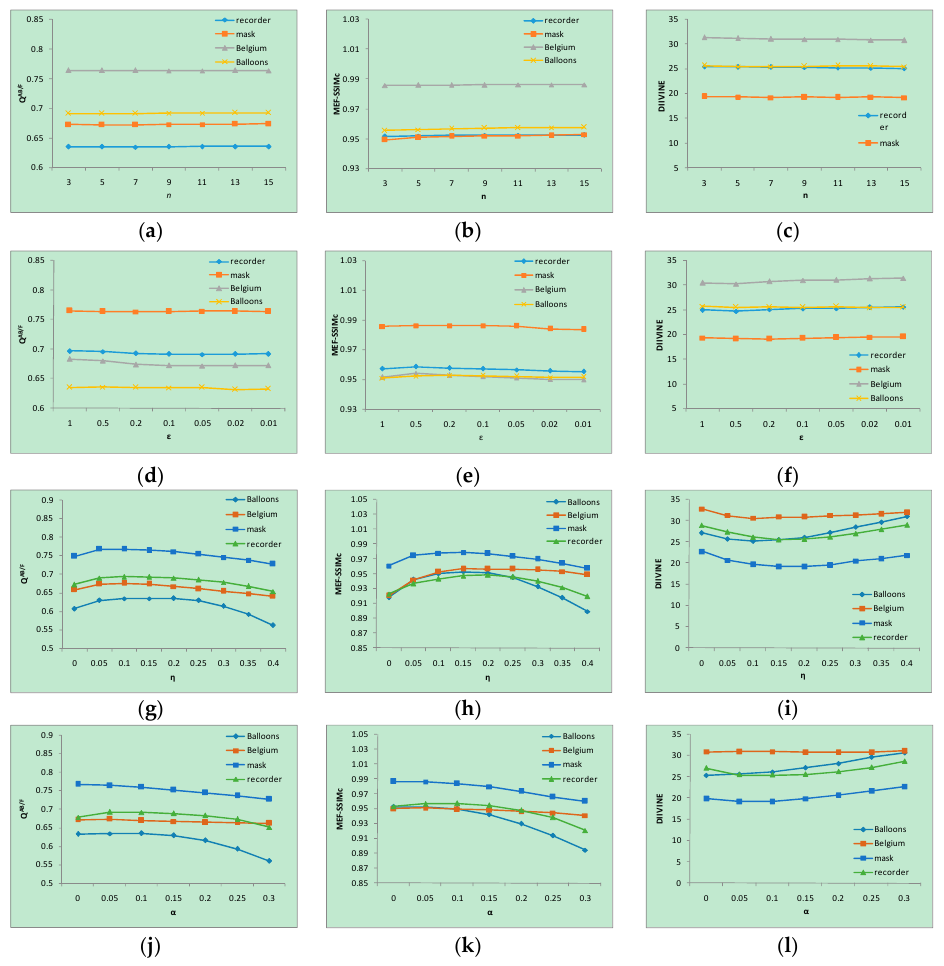
Figure 12. Performance of the proposed method with different parameters, i.e., ( a ) Q AB/F ~ n , ( b ) MEF-SSIMc ~ n , ( c ) DIIVINE ~ n , ( d ) Q AB/F ~ ε , ( e ) MEF-SSIMc ~ ε , ( f ) DIIVINE ~ ε , ( g ) Q AB/F ~ η , ( h ) MEF-